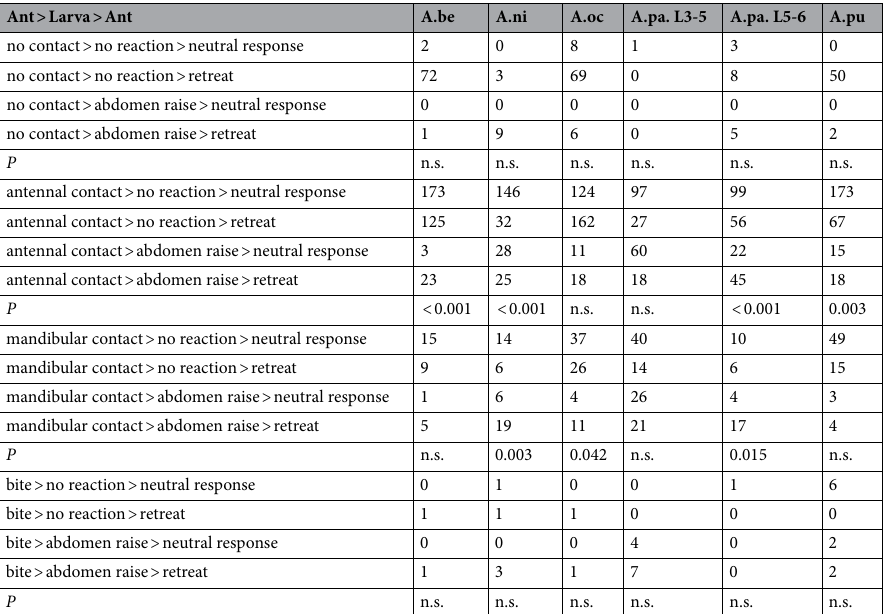
Table 2. Behavioral transitions of ant-larva-ant events between Myrmica rubra ants and an Arge sawfly larva in short-term interactions. The interaction frequencies are described by following three successive behaviors. First, the ant either approached the larva without contacting it, had an antennal contact, had mandibular contact, or bit it. Second, the larva had its abdomen either raised, or not. Third, the ant could either retreat, or not (i.e., neutral response). Sawfly species/instars (see Table 1) are: A. berberidis (A.be.), A. nigripes (A.ni.), A. ochropus (A.oc.), A. pagana (A.pa. L3-5 and L5-6), and A. pullata (A.pu.). Statistical results were obtained by Fisher exact probability tests ( P , two-tailed), comparing the number of times a larva raising or not its abdomen was followed by an ant’s neutral response or retreat. P > 0.05 (n.s.).